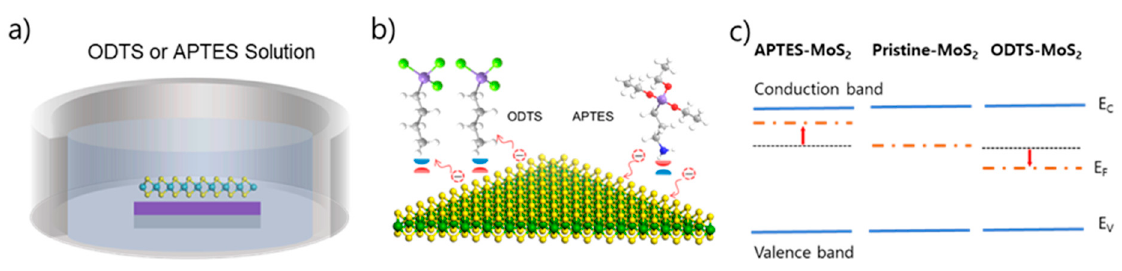
Figure 1. ( a ) A schematic illustration of the surface functionalization of either ODTS (Octadecyltrichlosilane) or APTES ((3-Aminopropyl)triethoxysilane) in a hexane solution. ( b ) ODTS and APTES molecules that withdraw and donate electrons from the MoS 2 monolayer. ( c ) Energy band diagram of MoS 2 monolayer depicting the change in the Fermi-level upon surface functionalization with either ODTS or APTES.